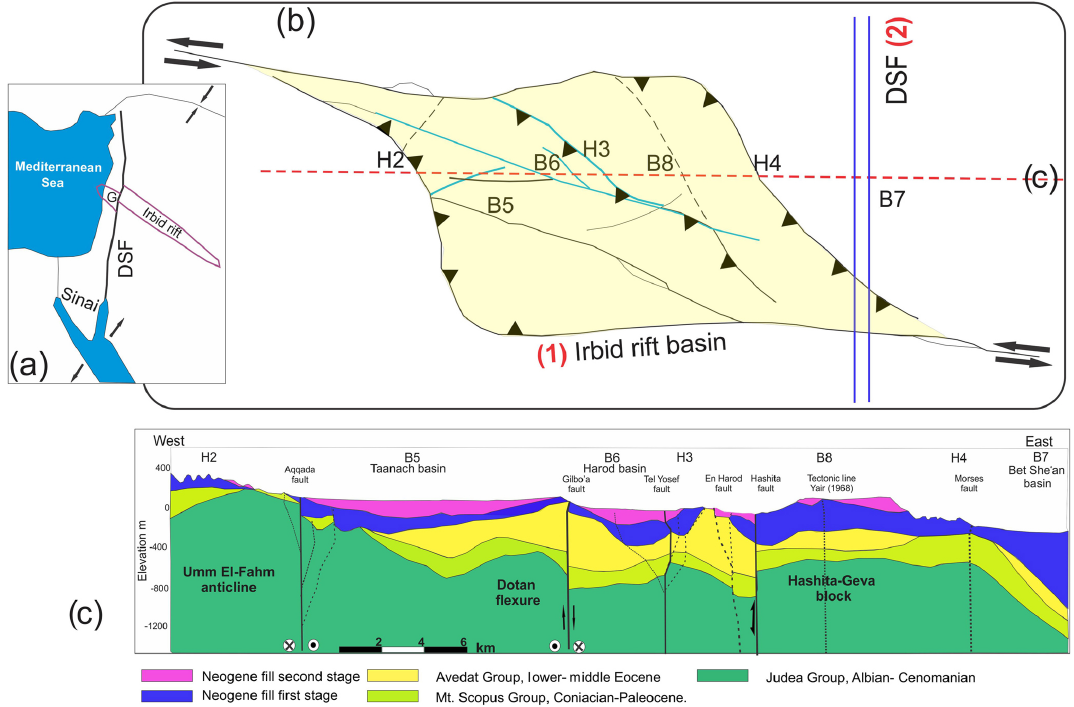
Figure 13. (a) Current plan view of the northwest-trending Irbid rift dissected by the Dead Sea fault plate boundary. (b) Neogene basin subsidence across the Galilee during the Irbid rifting (marked as first stage). NNE elongation provoked extension across the interpreted normal faults (marked by celeste lines). The second stage reflects the Dead Sea fault (DSF) stress regime, during which subsidence, normal faulting, and graben formation decrease, while complex strike-slip faulting characterizes the strain style. An establishment of a left-lateral strike-slip primary deformation zone – PDZ; modified after McClay and Bonora (2001). (c) East–west geological cross section through basins B5, B6, B8, and B7 (location: Figs. 3 and 13b). The profile is extracted from a structural model constructed for the entire study area based on seismic data, wells, and outcrops. Blue and pink shading represent the first and second subsidence stages, respectively. An inverted relief of tilted blocks is a result of a Pliocene–Pleistocene ESE compressional stress component of the Dead Sea fault stress regime. Dotted lines: less verified fault